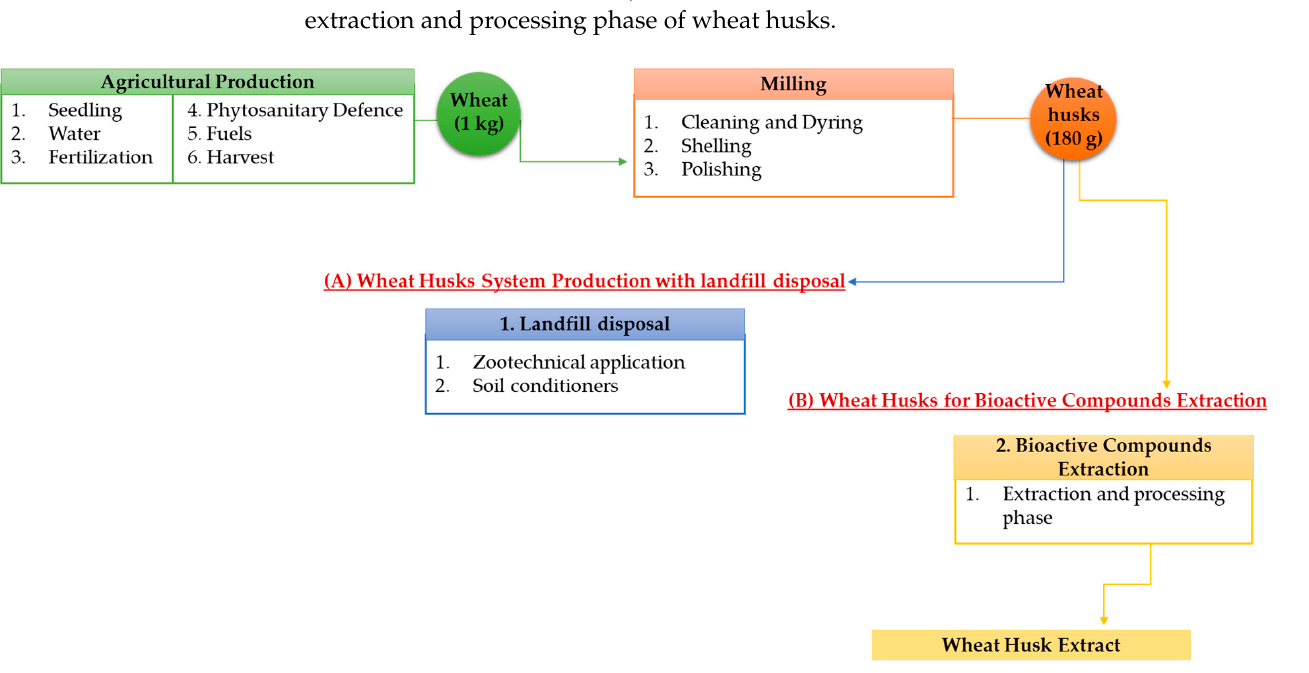
Figure 3. System Boundary of Durum Wheat Production considering ( A ) wheat husks for landfill disposal and ( B ) wheat husks for bioactive compounds extraction.